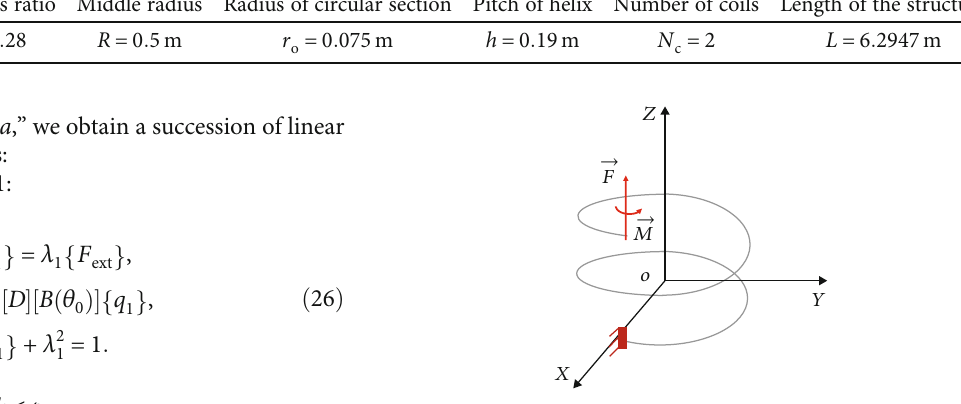
Figure 4: Recessed-loaded helical